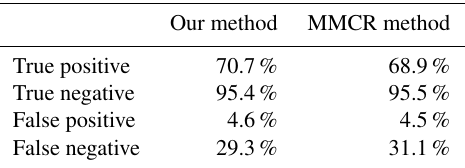
Table 3. Confusion matrix of KAZR mask results from our method and the ARM MMCR algorithm estimated by MPL